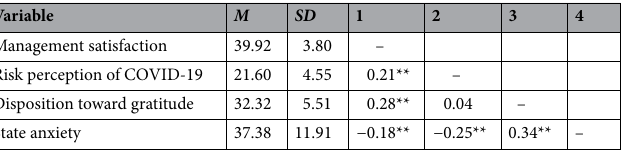
Table 3. Descriptive statistics and correlation analysis for questionnaires (N = 808). **p < 0.01 Bonferroni- corrected (×